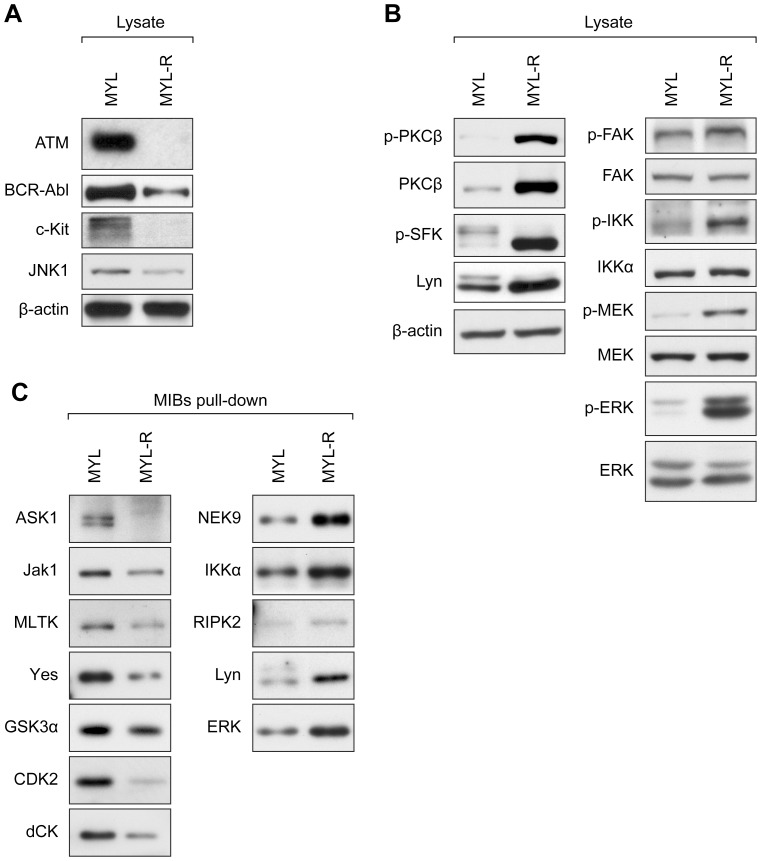
Validation of the MYL-R kinome profiles by immunoblotting.(A and B) MYL and MYL-R cell lysates were analyzed by immunoblot with the antibodies indicated. Representative data are shown. (A) ATM, BCR-Abl and c-Kit were decreased in MYL-R relative to MYL cells as predicted from the kinome profile above. (B, left panel) Both total and activated Lyn and PKCβ were increased in MYL-R cells as shown using antibodies to detect phosphorylation of the activation loop of Lyn (p-Y416) or the autophosphorylation site of PKCβ. (B, right panel) Total amounts of IKKα, MEK2 and ERK1/2 were similar in MYL and MYL-R cells, however, phospho-specific antibodies demonstrated these kinases were more active in MYL-R cells. (C) Kinases from MYL and MYL-R cell lysates were captured by MIBs pull-down and analyzed by immunoblot using antibodies directed against total protein. The relative amounts of kinases captured from each cell lysate correlated with the abundance ratios predicted by the MYL-R kinome profile. MIBs exposed to MYL-R cell lysate (C, left panel) captured less ASK1, Jak1, MLTK, Yes, GSK3α, CDK2 and dCK; and (C, right panel) captured more NEK9, IKKα, RIPK2, Lyn and ERK. See also, Figures S2 and S3.